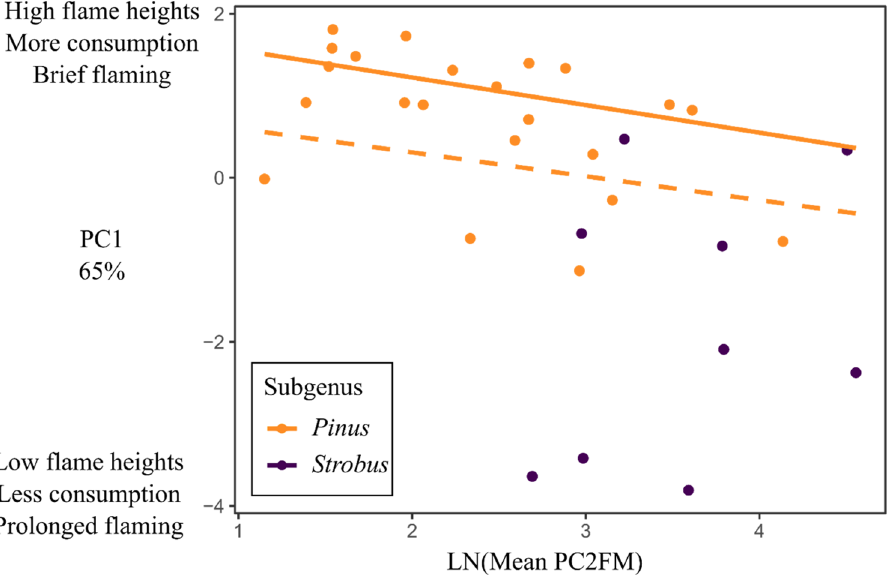
Figure 6. Relationship between flammability (PC1) and log transformed mean fire return interval based on PC2FM for species in the Pinus and Strobus subgenera. Dashed line represents PGLS regression line for the entire Pinus subgenus. Solid line represents the PGLS regression without the five species in the Pinus and Contortae subsections. No significant model could be fit to the Strobus